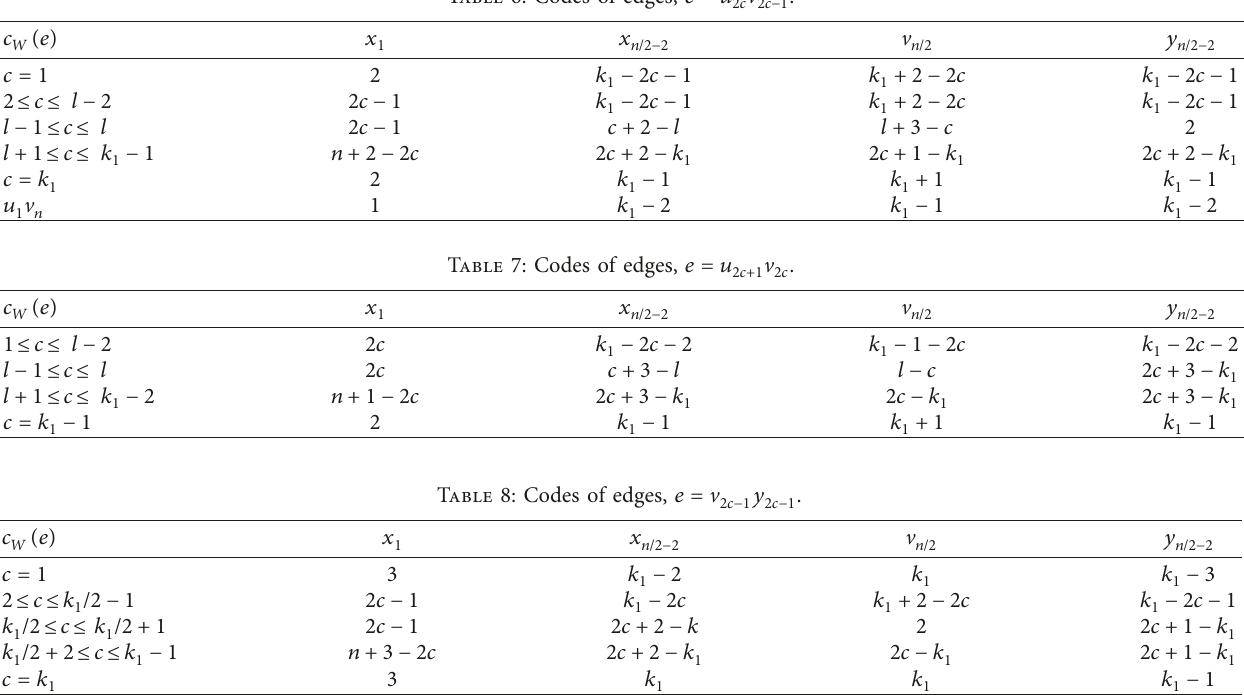
Table 6: Codes of edges, e � u